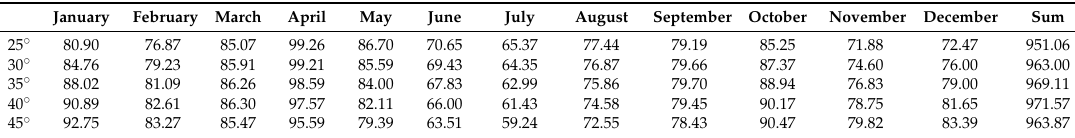
Table 6. Variation of monthly PV output according to different angles of array tilt.